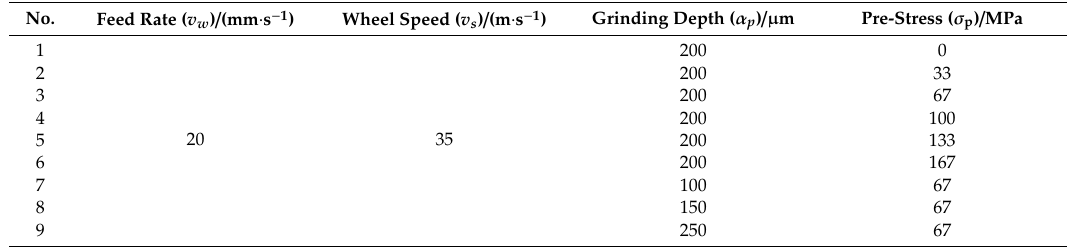
Table 2. Grinding parameters of pre-stress hardening grinding (PSHG) tests.